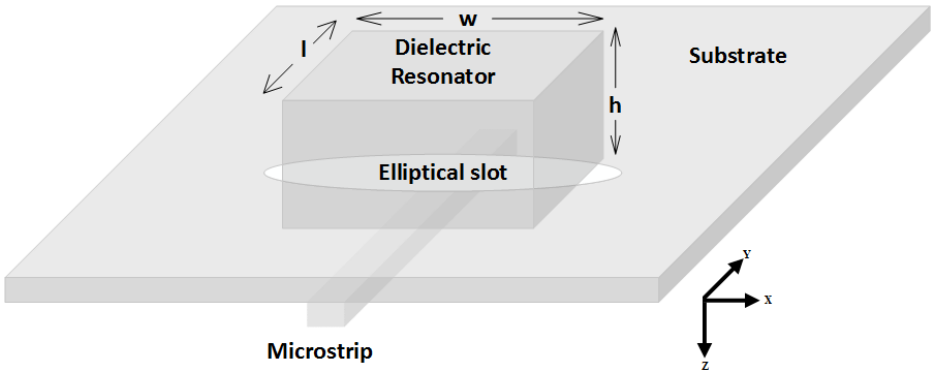
Figure 2. The 3D geometry of the proposed RDR coupled to an ES at the bottom